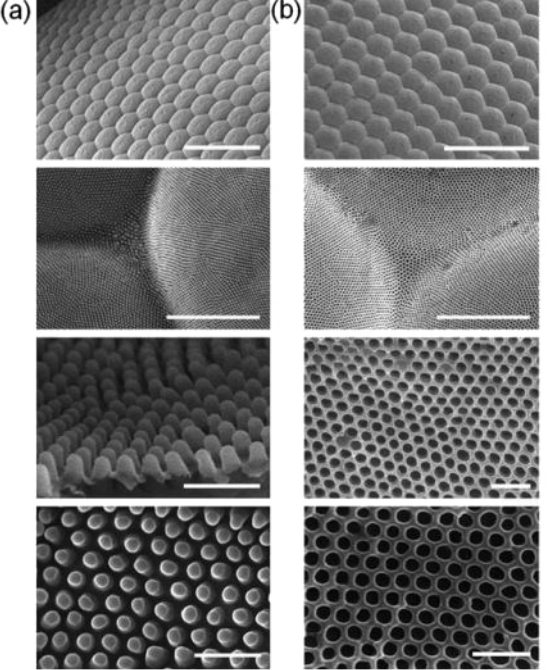
Figure 12. Anti-reflective structures of the moth eye and fabrication of biomimetic moth eye structures. Scanning electron microscopy (SEM) images of ( a ) various views of Attacus atlas moth eye demonstrating the conical protuberances on its surface and ( b ) similar views of the negative mold of moth eye produced using perfluoropolyether (PFPE), which can then be used to fabricate artificial moth eye-like nanostructures using the soft imprint lithographic method. Scale bars: first row images = 100 µ m, second row images = 5 µ m, and third and fourth row images = 500 nm. Reproduced from [65] with permission of The Royal Society of